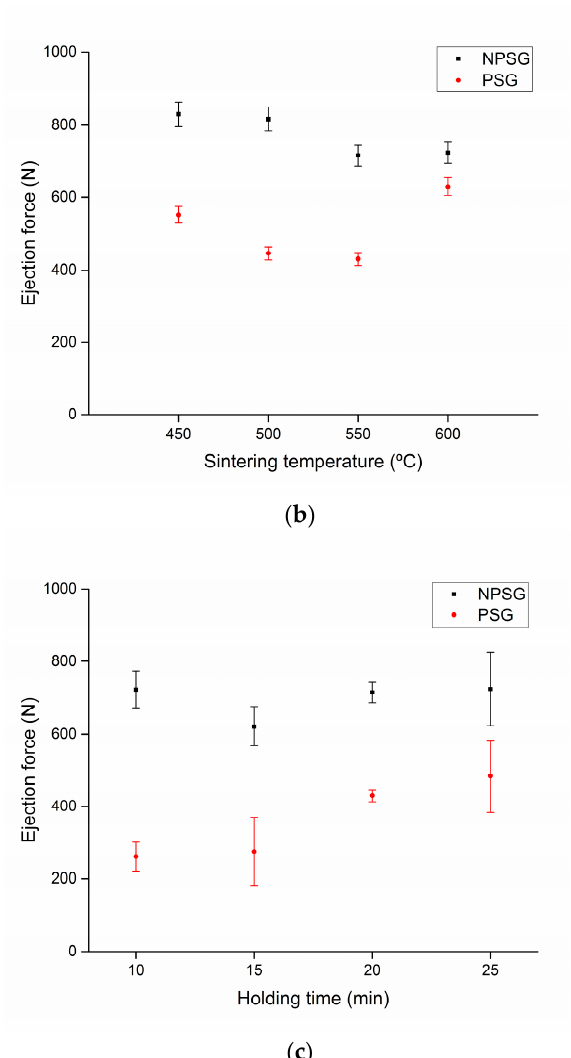
Figure 7. Diagrams showing the experimental values of ejection force measured during the ejection of the micro-gears with respect to the process parameters. ( a ) The four level of punch pressure with constant sintering temperature (550 °C) and holding time (20 min); ( b ) the four level of sintering temperatures with constant punch pressure (150 MPa) and holding time (20 min); and ( c ) the four level of holding time with constant punch pressure (150 MPa) and sintering temperature (550 °C).